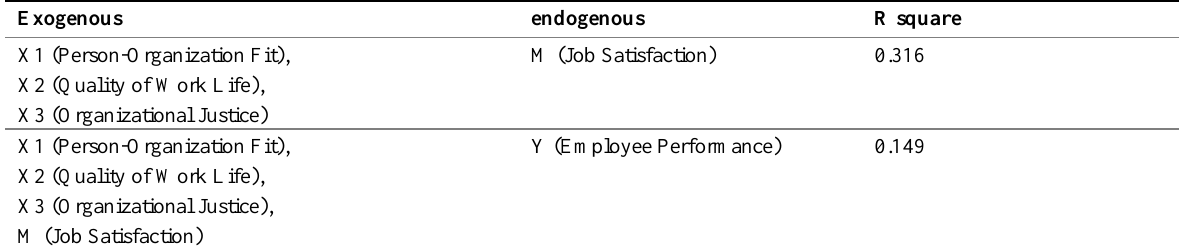
Table 2: Table of determination coefficient results